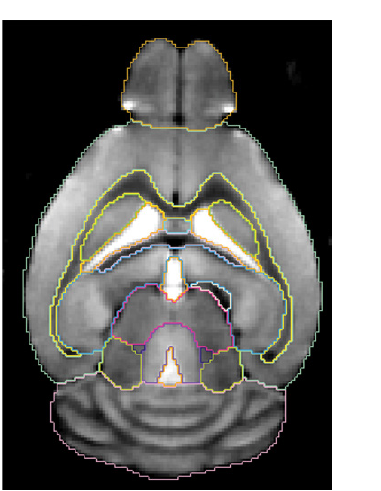
Figure 7. One axial image of the 3D MRM average in vivo brain with its atlas superimposed. The signal-to-noise ratio (SNR) is clearly superior to the single brain atlases (compare with Figures 5 and 6